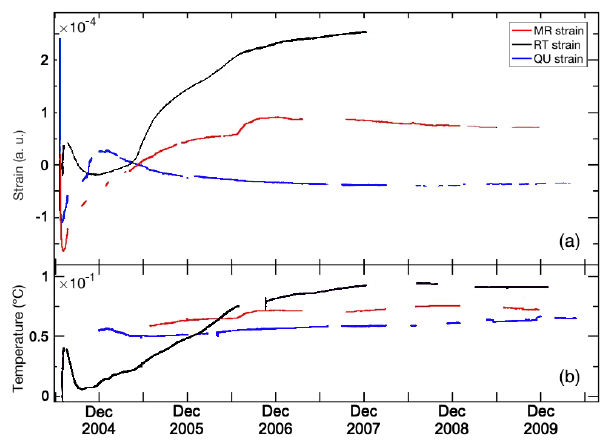
Figure 4. Time series of the raw, unfiltered, 60s downsampled strain and temperature signals. Data are represented from instal- lation up to 30 June 2010. The upper panel shows the strain (di- mensionless and plotted relative to an arbitrary datum) recorded by the three instruments, while the lower panel represents the change in temperature recorded by the low-sensitivity output, expressed in Celsius